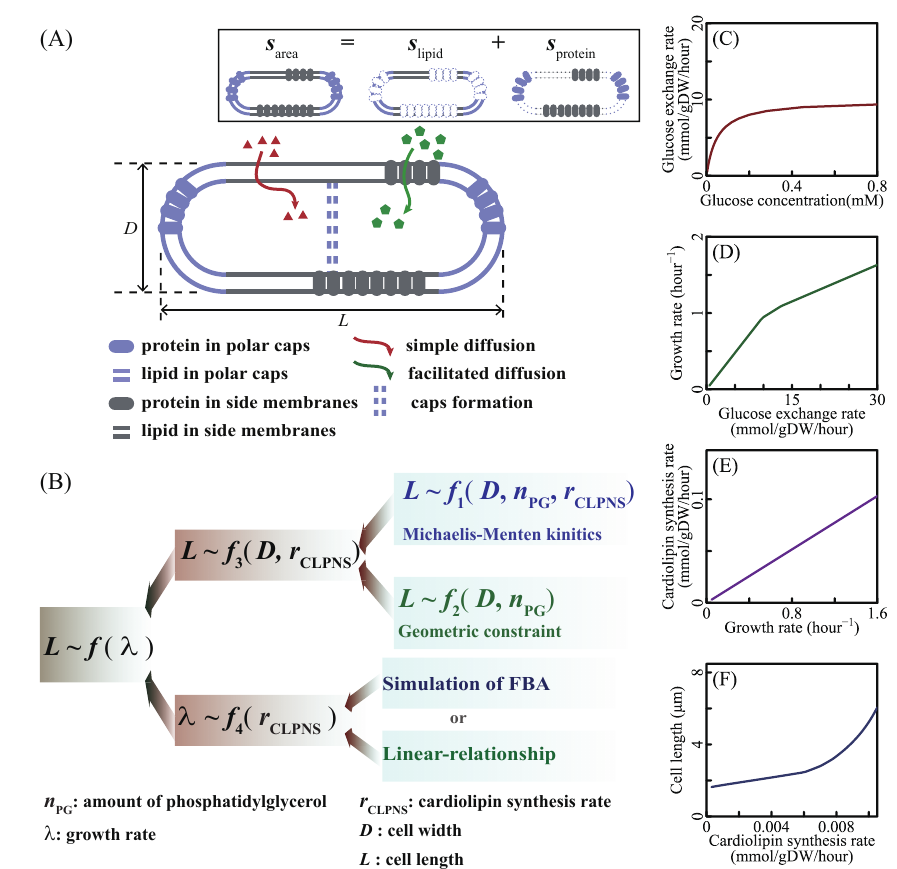
Figure 1. Overview of modeling approaches. ( A ) Gram-negative bacteria have an inner membrane and an outer membrane, both of which are lipid bilayers embedded with membrane proteins. According to the membrane structure, the cell surface area is the function of the amount of phospholipid. ( B ) f 1 refers to the Michaelis–Menten equation of cardiolipin biosynthesis reaction, which sets a constraint among the amount of phosphatidylglycerol, cardiolipin synthesis rate, cell length and cell width (see Equation (18)). f 2 is another constraint deriving from cell membrane structure (see Equation (7)). According to f 1 and f 2 , f 3 is written as Equation (20). The relationship between the growth rate and cardiolipin synthesis rate was introduced by two ways in this work. One was based on the flux balance analysis, and another was assuming a linear equation directly. The function of cell length and growth rate was obtained by integrated f 3 and f 4 . ( C – F ) Simulations of iJR904 [35] whose bounds correspond to the M9 minimal medium [25,73,74] with glucose (written in Table S1). Exchange rates of nutrients depend on the nutrient concentration. The increase of nutrient exchange rates leads to fast growth rate. The flux balance analysis of genome-scale metabolic network infers that the cardiolipin synthesis rate changes linearly with the growth rate when bacteria grow with same bottleneck reactions. According to Equation (20), cell length increases with cardiolipin synthesis